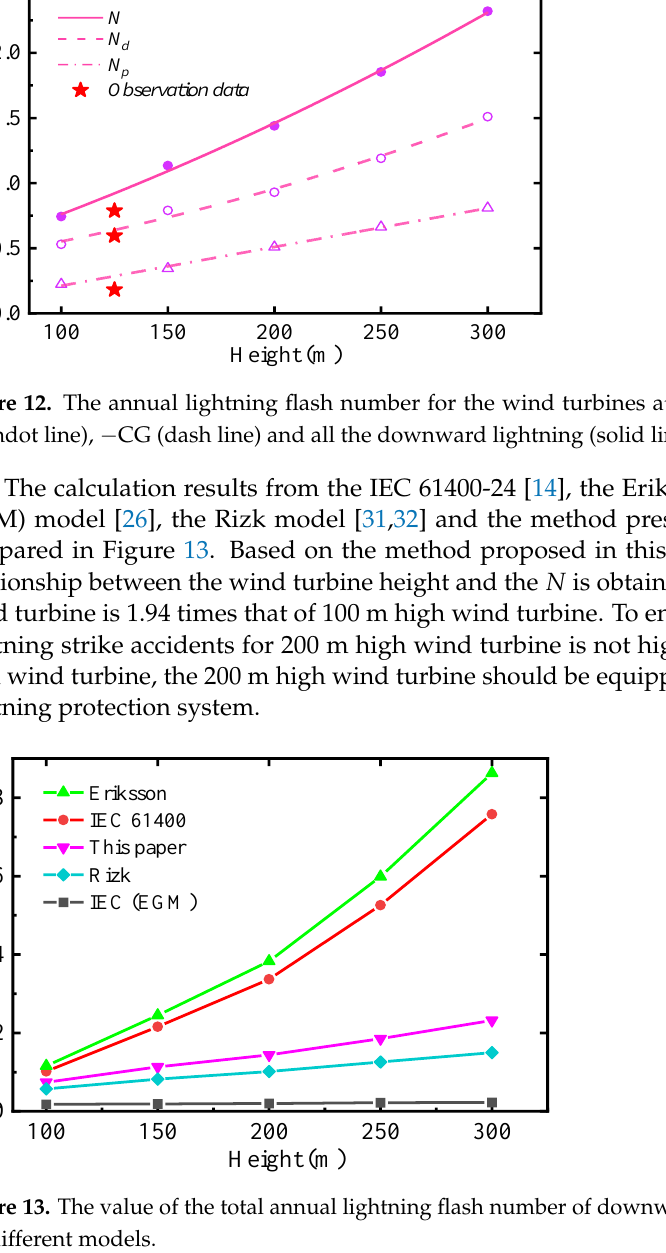
Figure 13. The value of the total annual lightning flash number of downward lightning calculated by the different models.